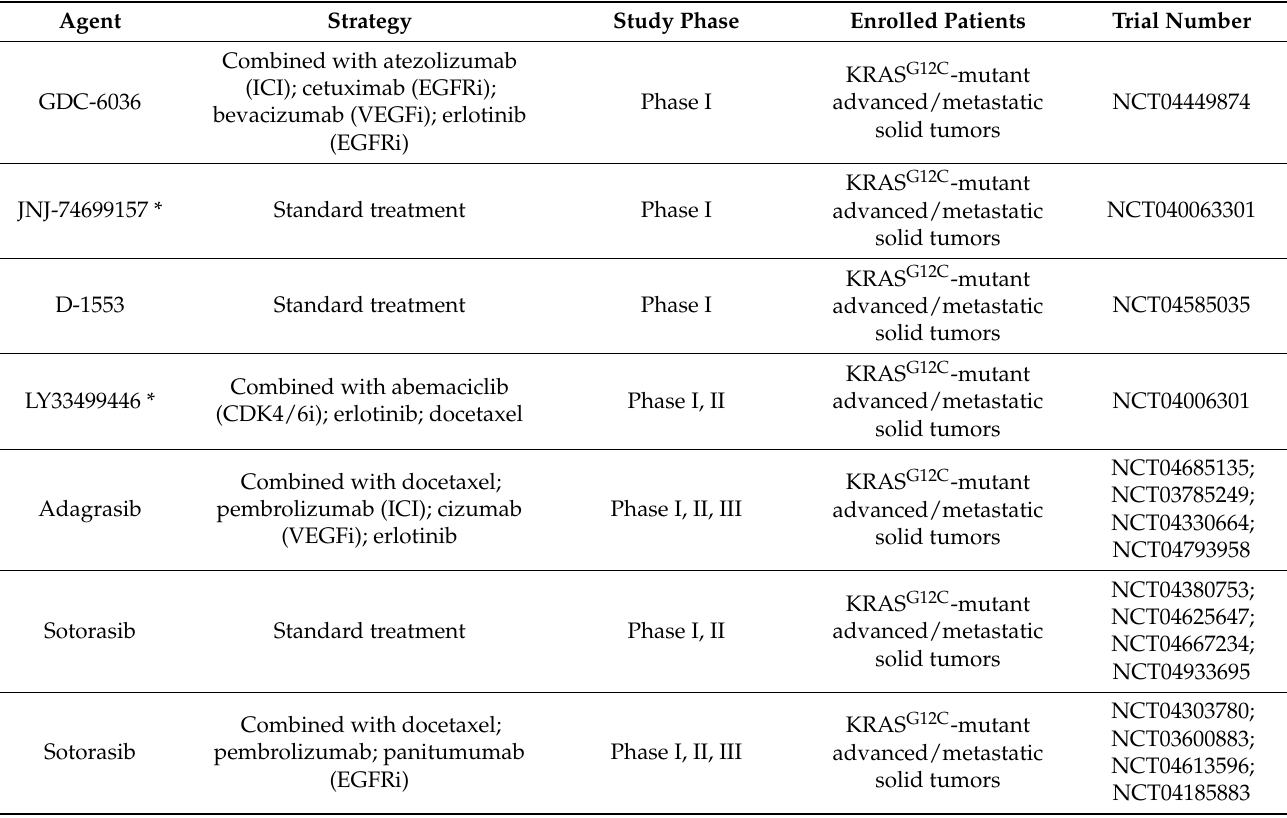
Table 1. KRAS G12C inhibitors in clinical